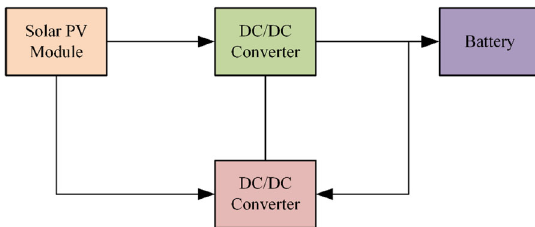
Fig. 3 Block diagram of PV system with MPPT charger